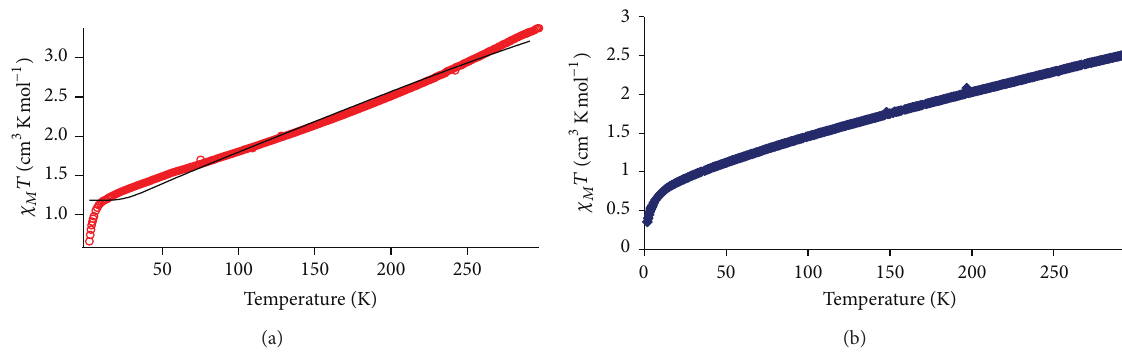
Figure 4: Plot of 𝜒 𝑀 𝑇 versus 𝑇 for (a) 1 (circles = experimental; line = theoretical) and (b) 2 .